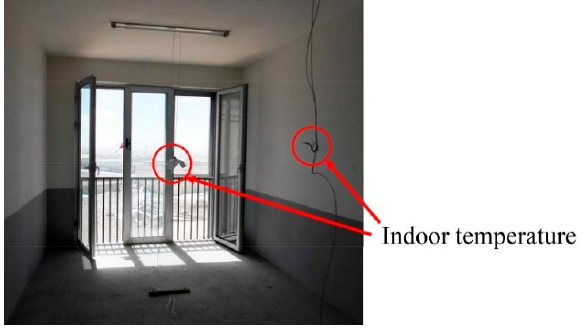
Figure 7. Indoor temperature test.